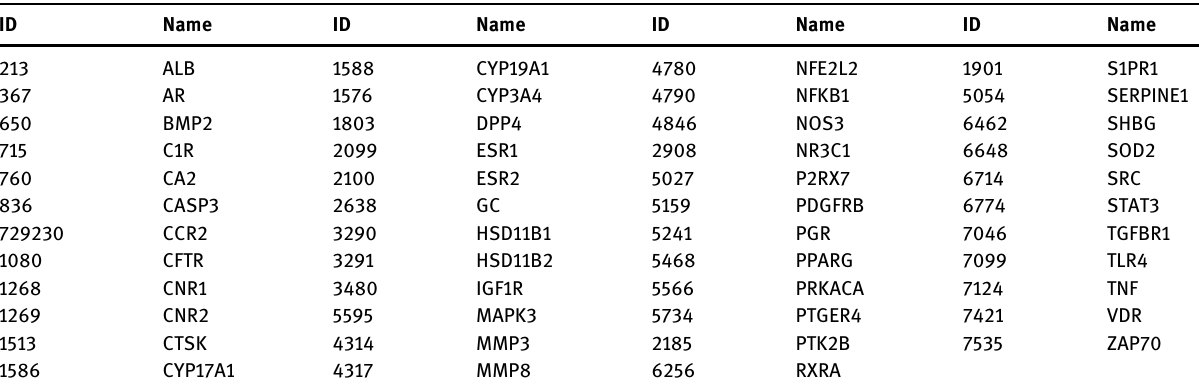
Table 1: The osteoporosis - related genes targeted by β - ecdysone